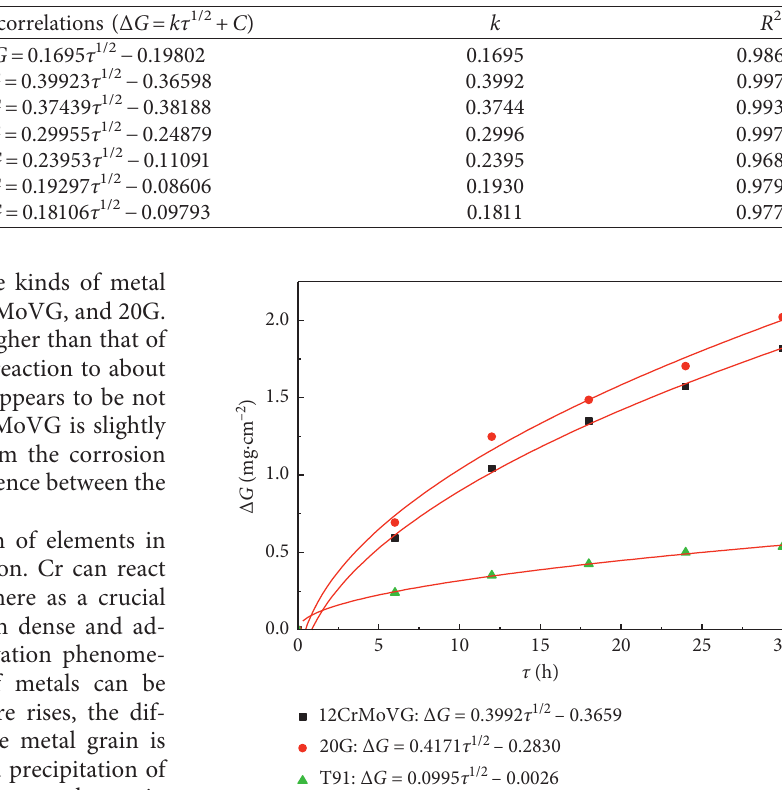
Table 4: Fitting correlations of corrosion mass gain of different metal samples coated with different fuel ash.